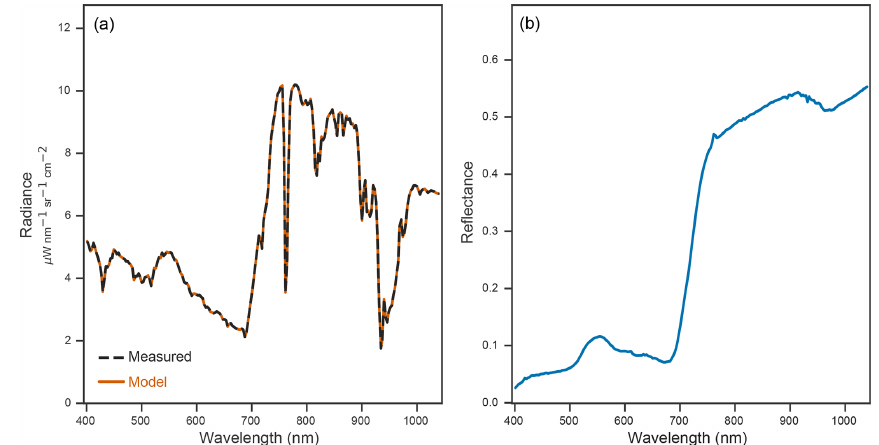
Figure 7. Example surface reflectance retrieval for a PRISM vegetation spectrum. Panel (a) shows the measured (black dashed spectrum) versus predicted (orange spectrum) radiance spectra. Panel (b) shows the retrieved surface reflectance spectrum (blue spectrum).